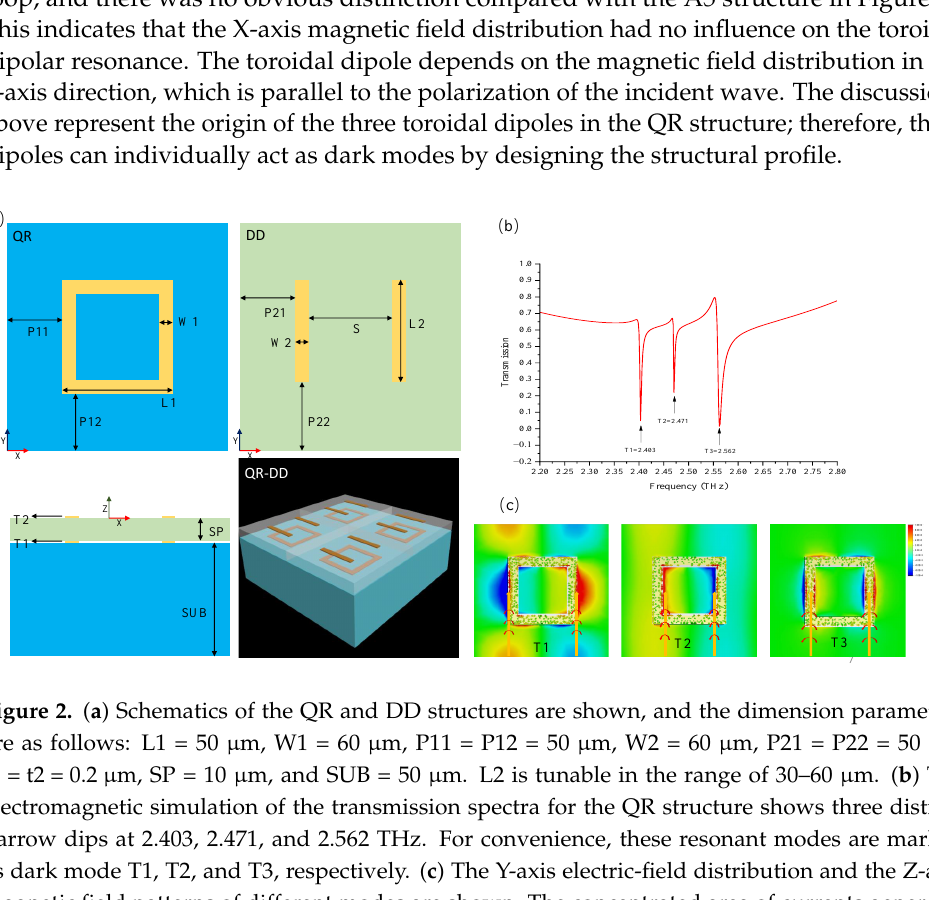
loop, and there was no obvious distinction compared with the A5 structure in Figure 3b.